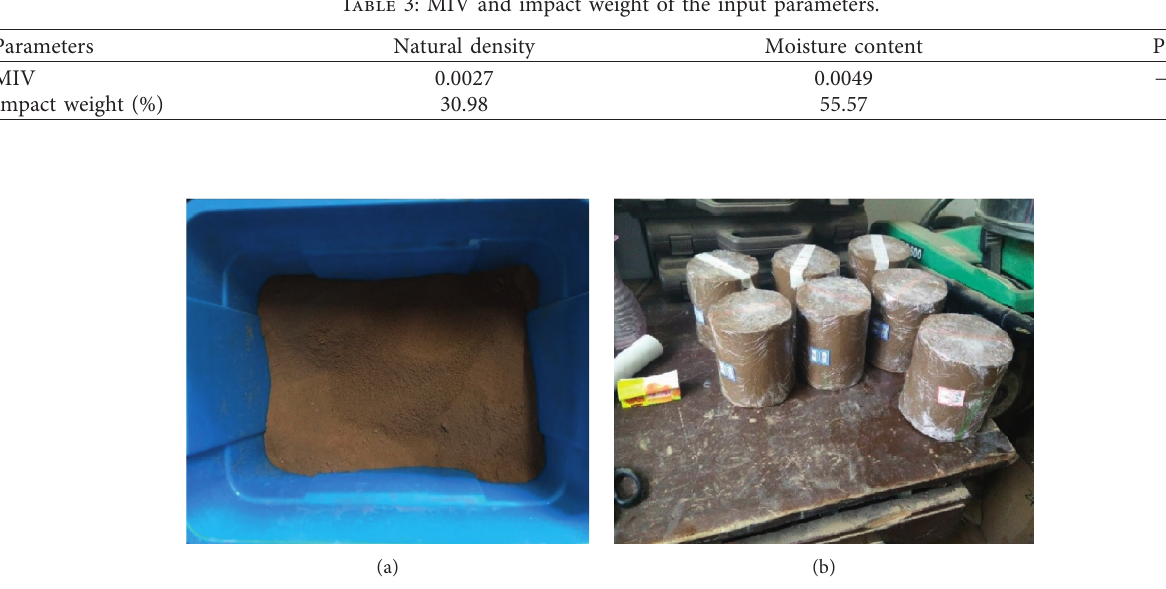
Figure 8: Remodeled soil experiment. (a) Dried soil particles. (b) Some remodeled soil samples.